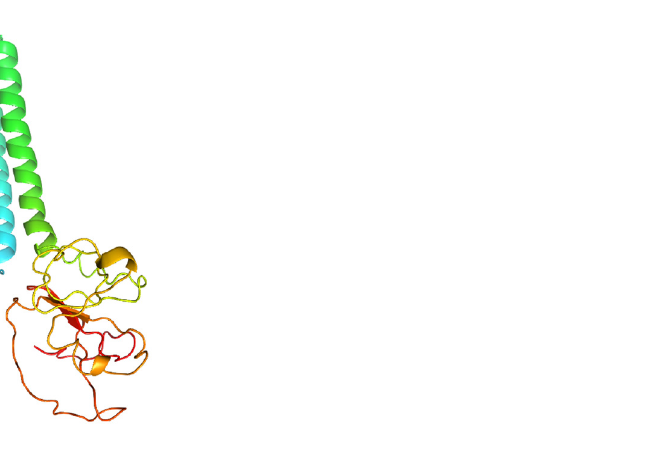
Figure 2. Predicted M protein structure of SARS-CoV-2 (ribbon diagram) using the software